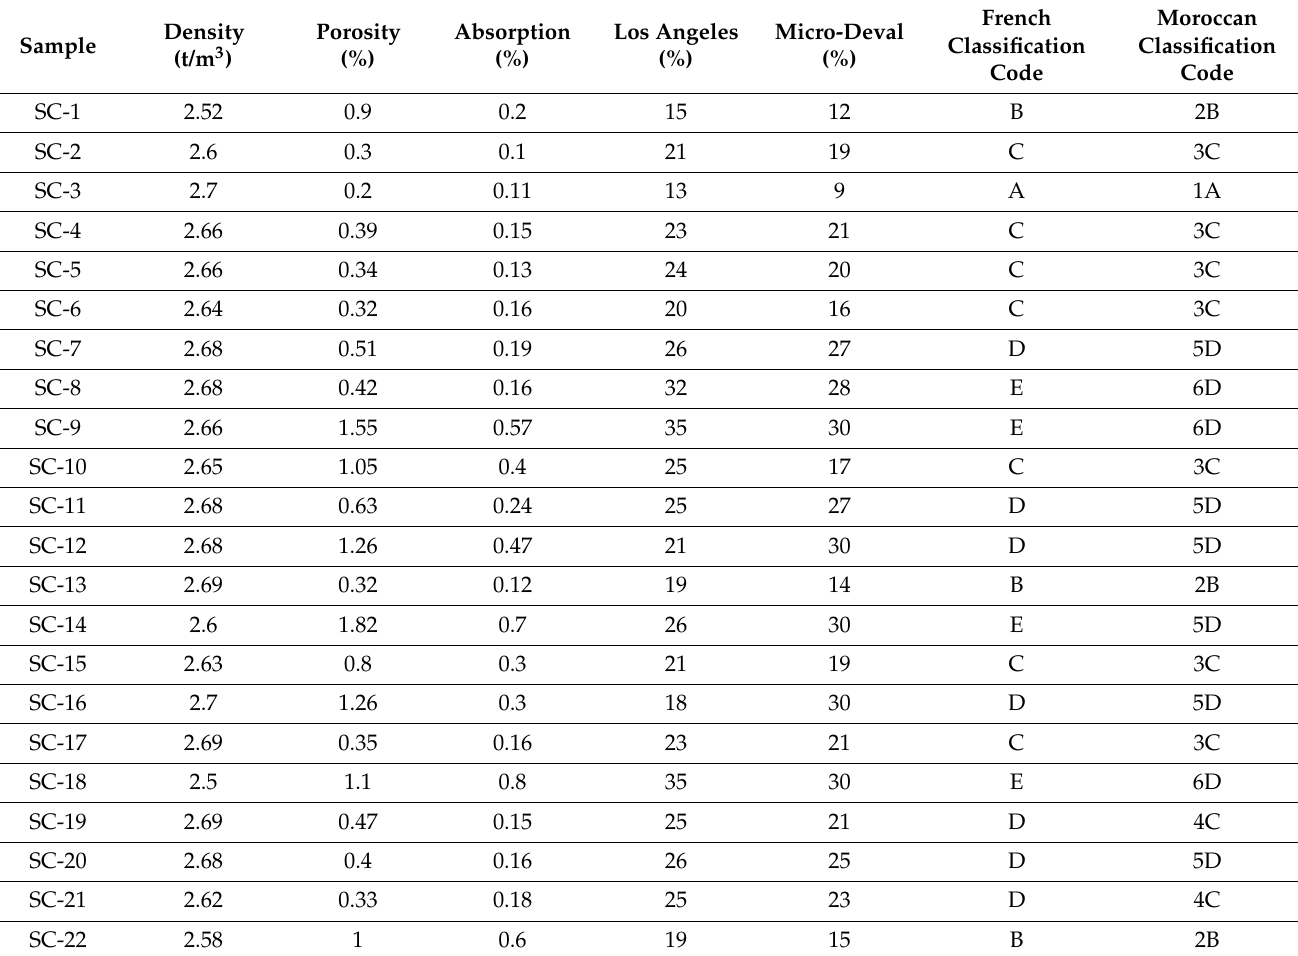
Table 4. Results of geotechnical analyses of the samples